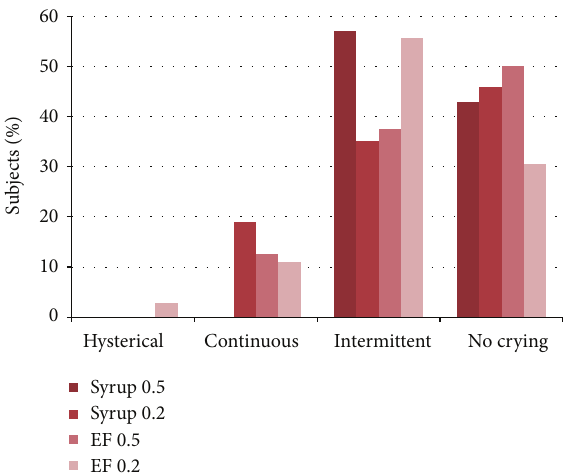
Figure 2: Percentage of children in Houpt categories of sleep in two study groups adjusted for age (dose 0.5 or 0.2 mg/kg).